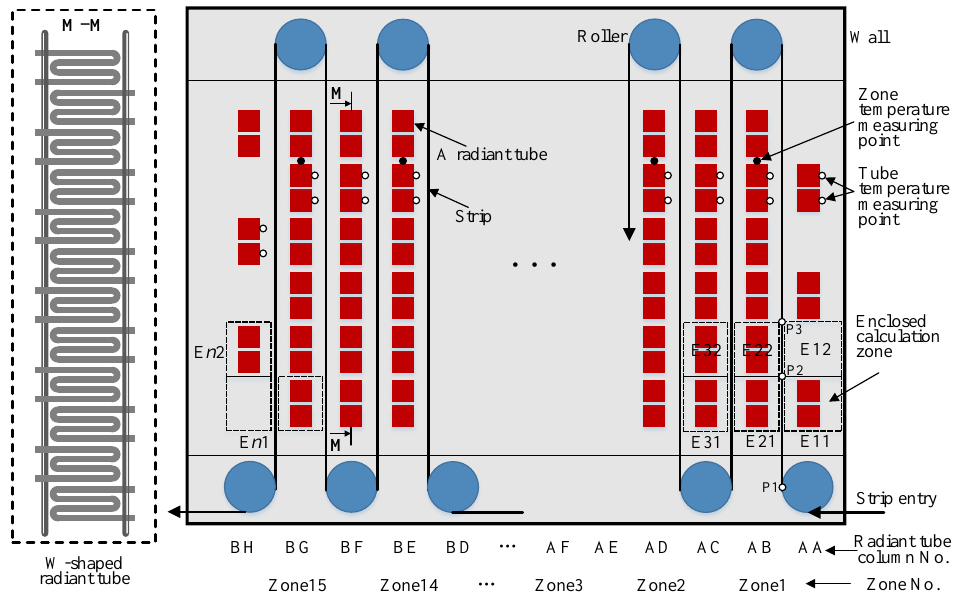
Figure 1. Schematic diagram of the RTF and division of the radiation heat transfer calculation